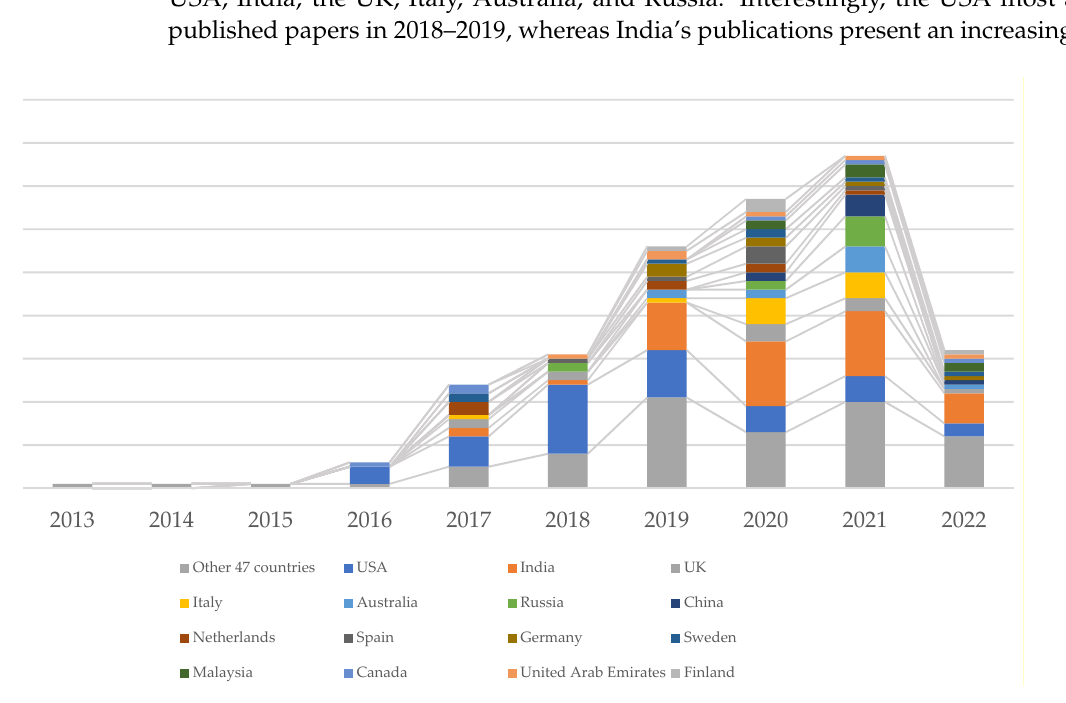
Figure 2. Literature by publishing year and principal authors’ locations. (Search conducted until 16 September 2022).